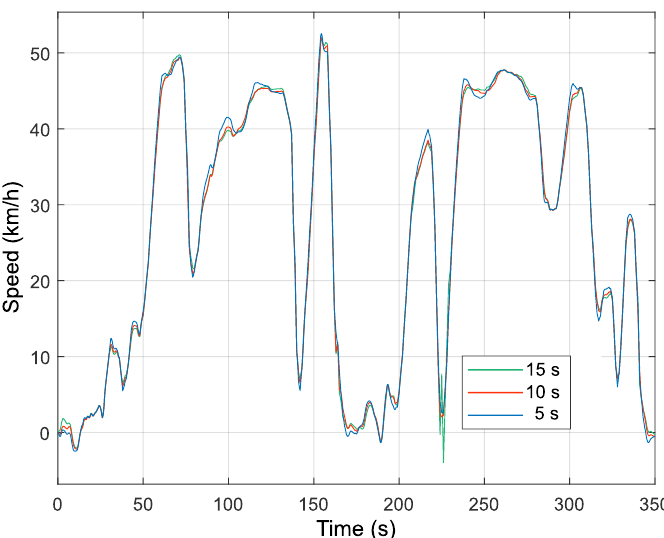
Figure 14. Comparison of PID and MPC controller.